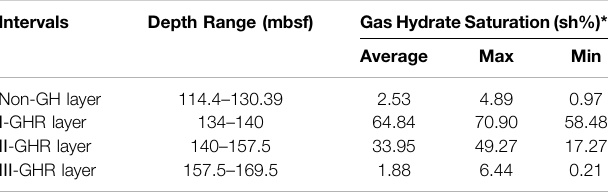
TABLE 3 | The statistics data of gas hydrate saturation data.